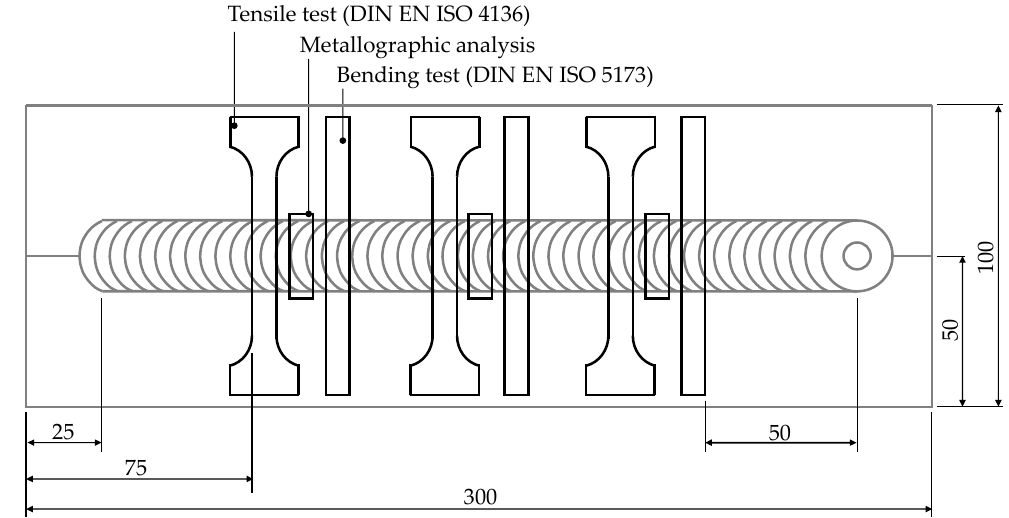
Figure 5. Position of the specimens and their prescribed position.